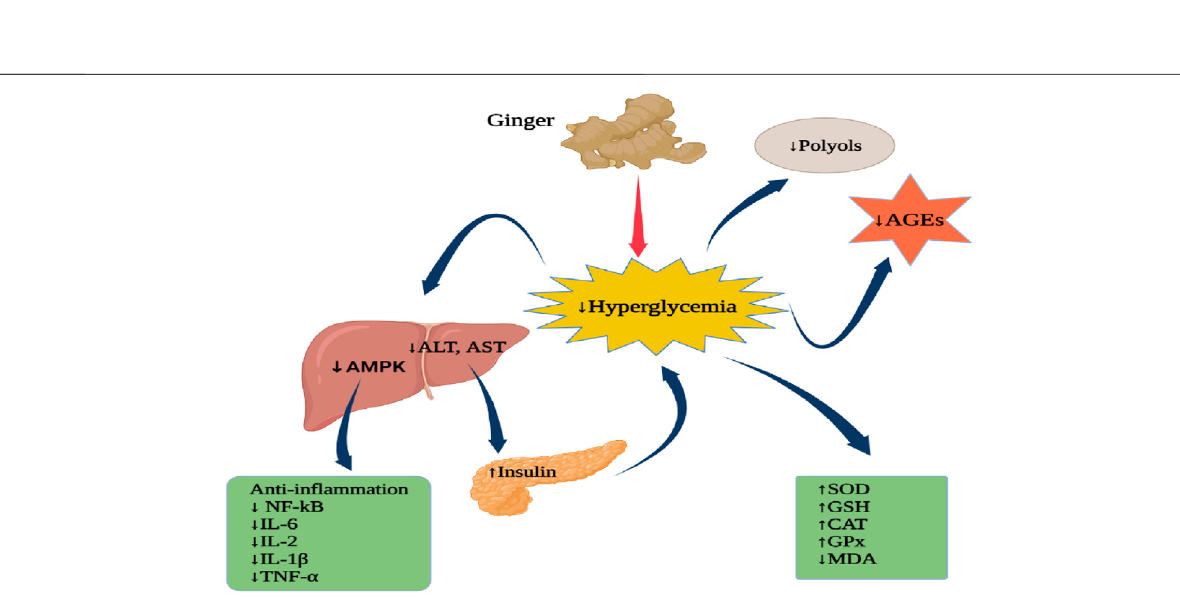
Frontiers in Pharmacology |